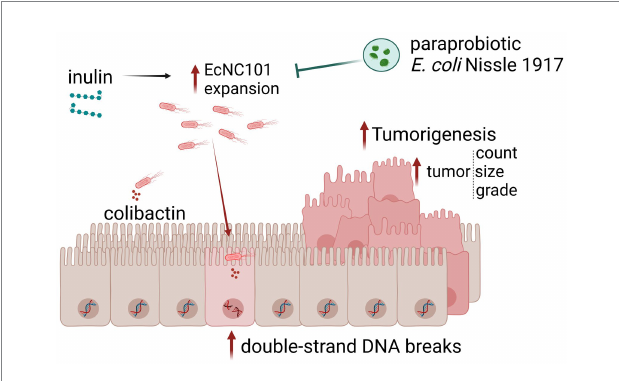
FIGURE 5 Schematic representation of the main findings of this work. Inulin supplementation promotes EcNC101 expansion in Apc Min/+ mice, resulting in increased DSBs, cell proliferation, and tumorigenesis. The paraprobiotic EcN suppresses inulin-enhanced EcNC101 colonization in the gut of Apc Min/+ mice resulting in lower